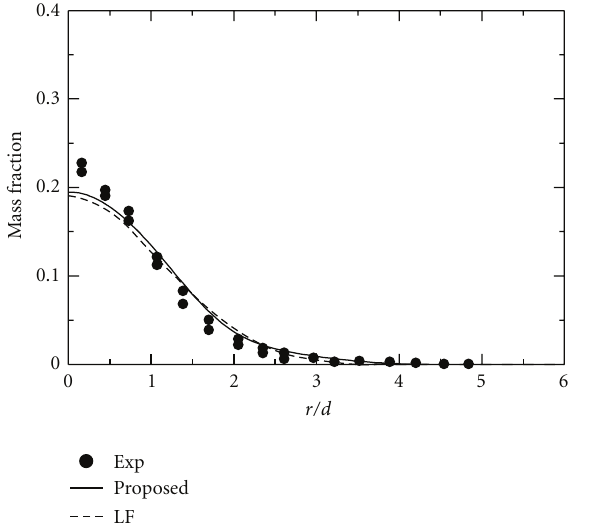
Figure 21: Radial mass fraction of H 2 O at x/d = 20.